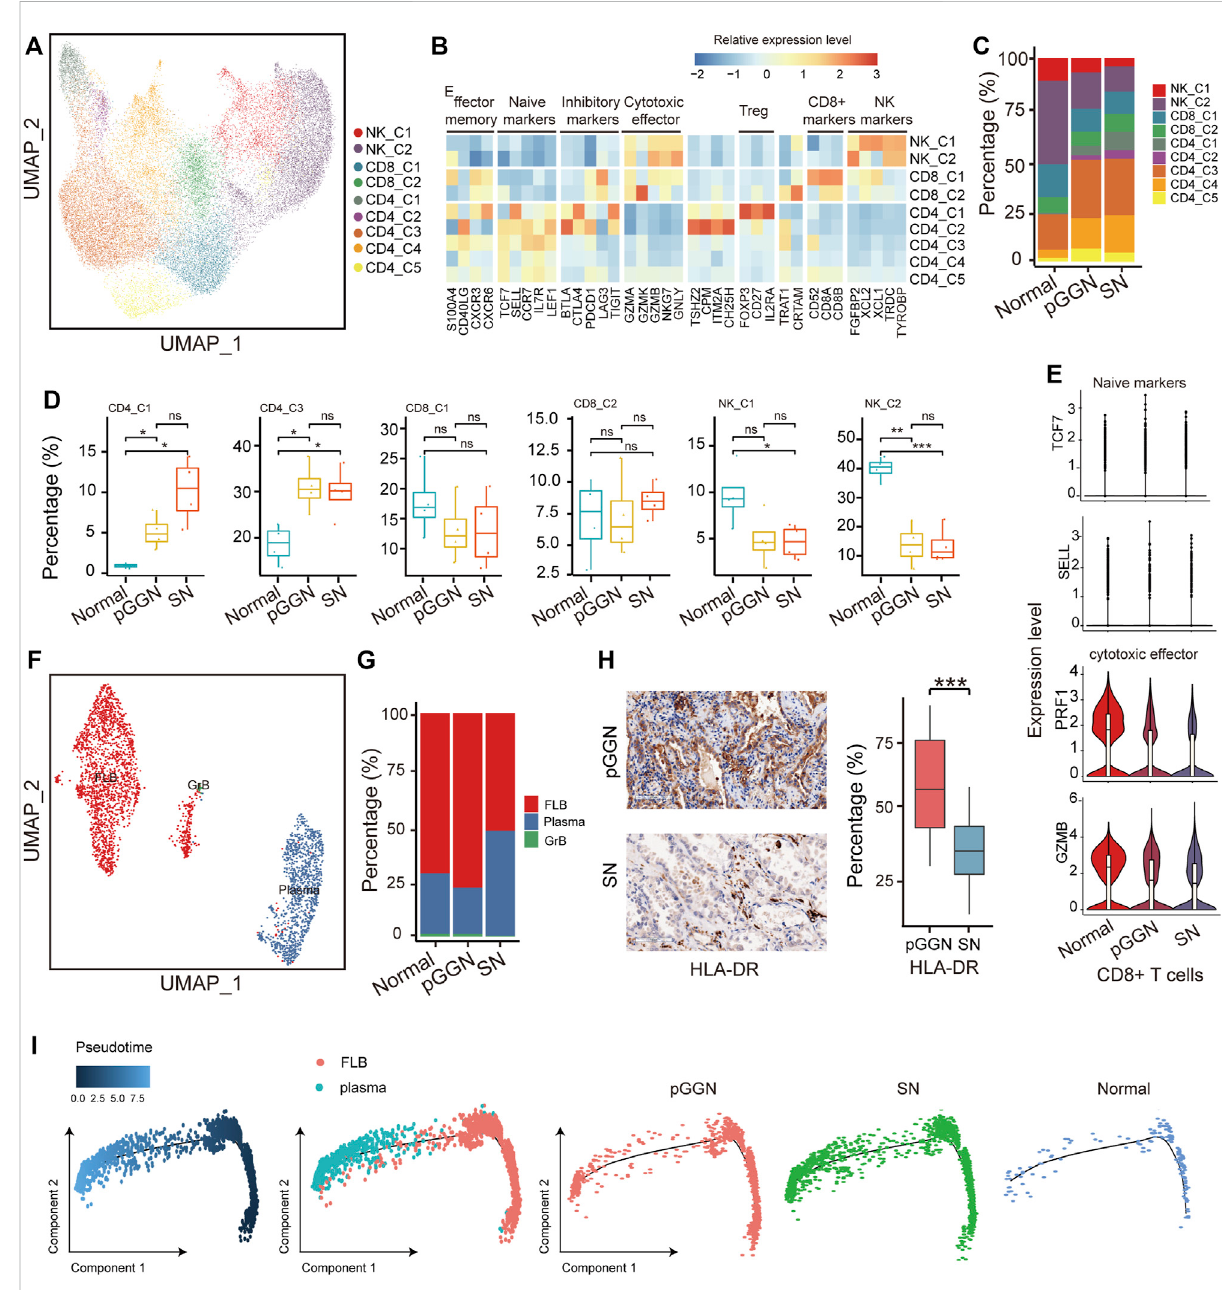
FIGURE 5 Tregs cells and plasma B cells increased with the progression of LUAD. (A) UMAP plot of NK/T cells, colored by 9 cell subsets. (B) The heatmap showedthemarkergenesofNK/Tcellsubsets. (C) Theproportionofmajorcellsubsetsamongeachtissueorigin. (D) Percentagesofthecellsubsets across pure GGNs, SNs, and normal tissues. Colored dots represent different samples. The comparison was performed using t -test. (E) The expressiondistributionofnaïvemarkersandcytotoxiceffectormarkersofCD8 + T-cellsineachtissueorigin. (F) UMAPplotofBcells,coloredby 3 cell subsets. (G) The proportion of cell subsets among each tissue origin. (H) The expression levels of HLA-DR in the pure GGN and SN tissues by immunohistochemical examination. The left was the representative images, and the comparison was performed using t -test. (I) Unsupervised transcriptional trajectory of follicular B cells and plasma B-cells from Monocle2, colored by pseudo time (left), cell types (middle), and tissue origin (right). Ns, p > 0.05; *, p ≤ 0.05; **, p ≤ 0.001; ***, p ≤ 0.0001. A p -value < 0.05 was considered statistically signi fi